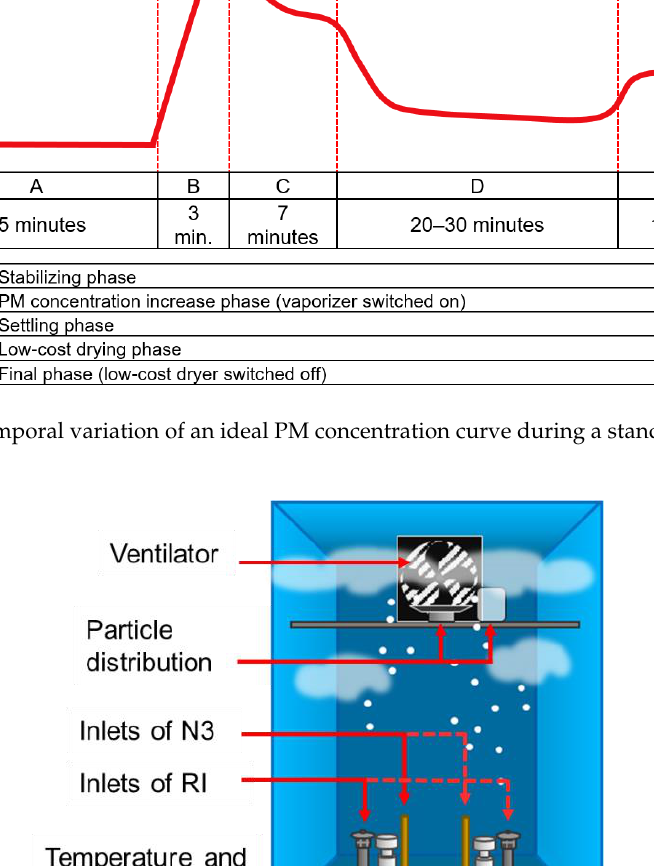
Figure 6. Temporal variation of an ideal PM concentration curve during a standard experiment.